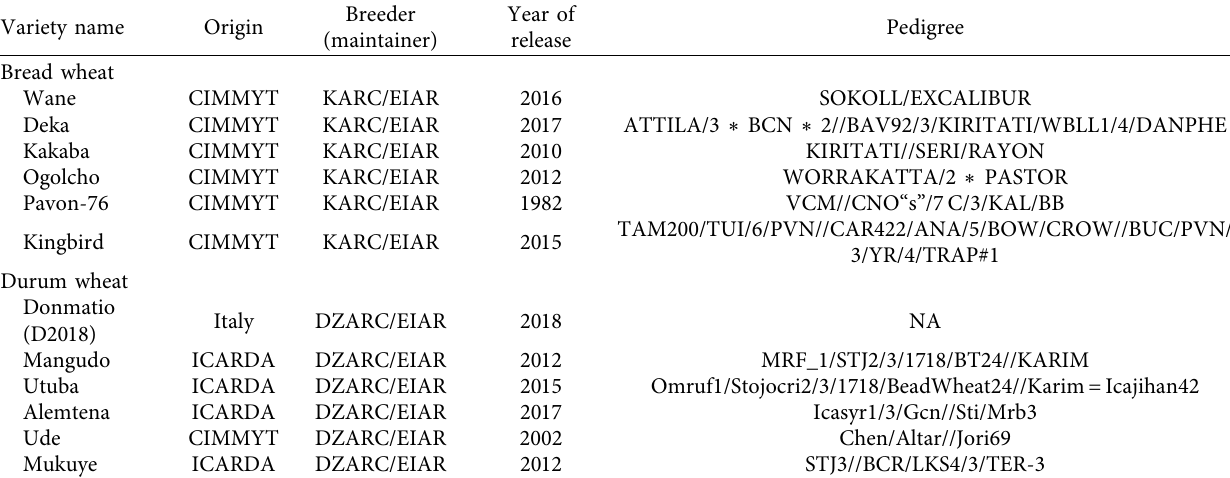
Table 1: Profile of bread and durum wheat varieties tested in this